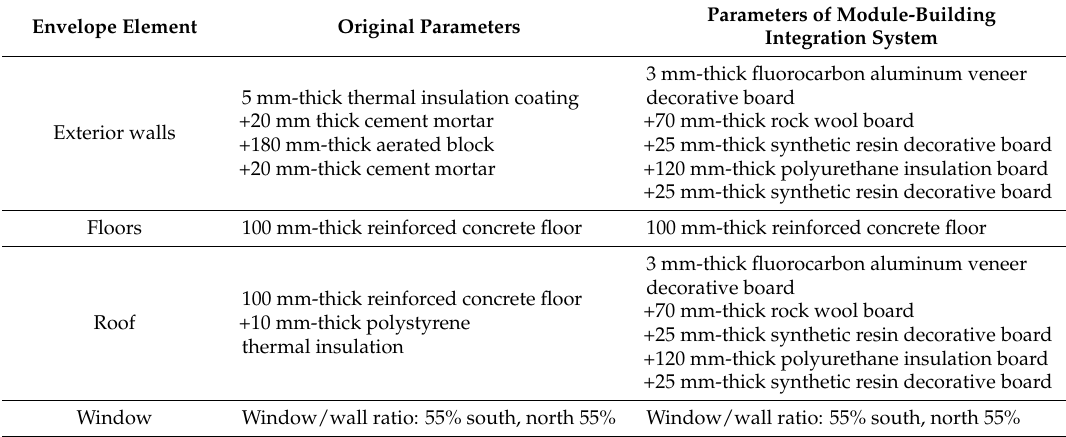
Table 3. Parameters of building